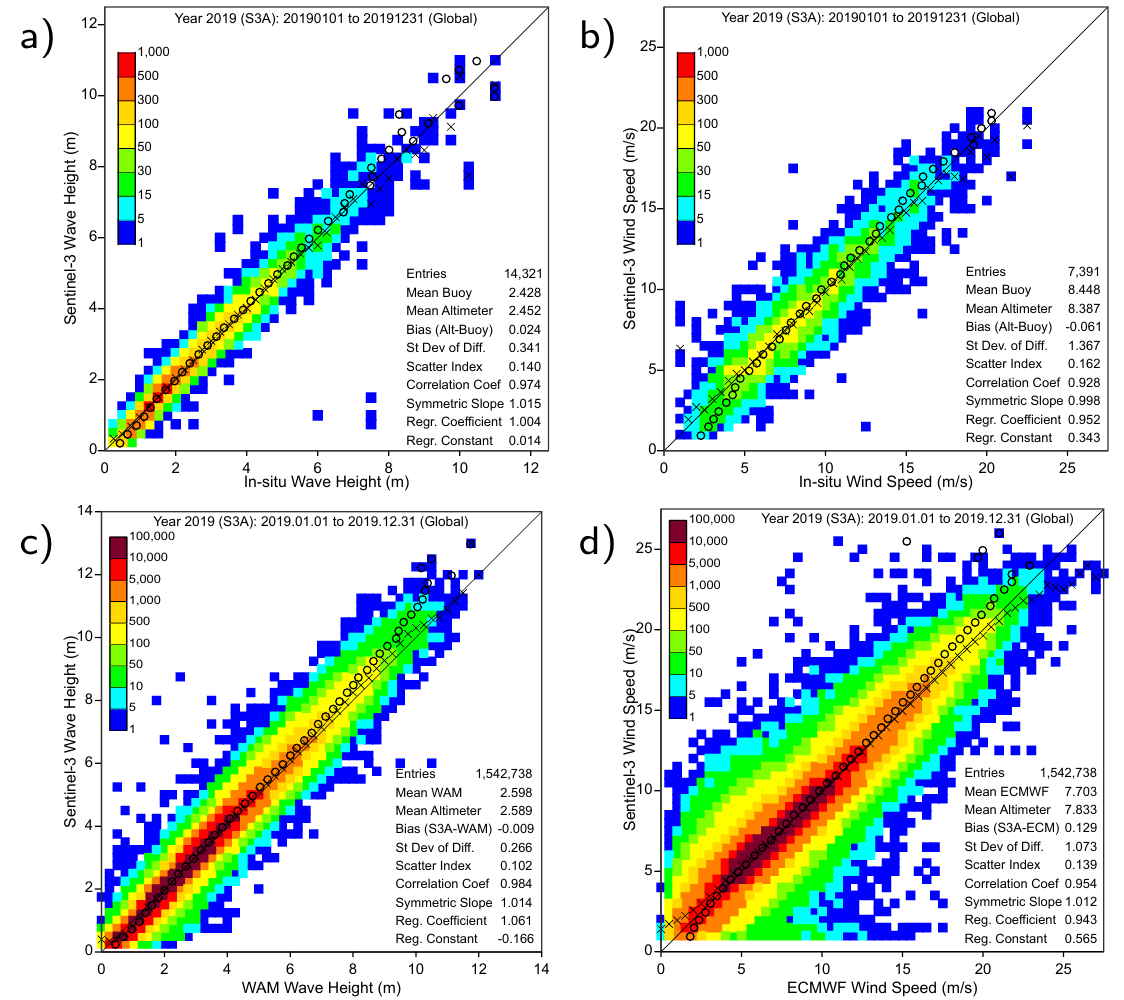
Figure 15. Comparison of S3A Wind and Wave Data for whole of 2019. ( a ) Wave height from buoys ( b ) Wind speed from buoys ( c ) Wave height from ECMWF WAM model (first guess) ( d ) Wind speed from ECMWF model (analysis). Plots are 2-D histograms with intervals of 0.5 m/s for wind speed and 0.25 m for SWH; the ‘x’ symbols mark the mean value of altimeter for given in situ, and the ‘o’ symbols show the mean of the in situ for a given altimeter